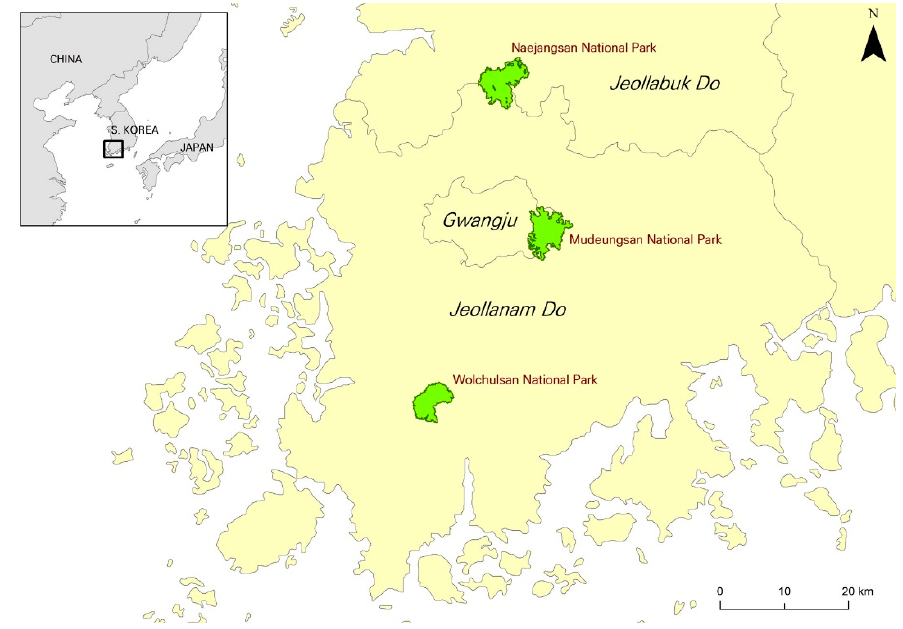
Figure 2. The research site: Three national parks in southwestern Korea.